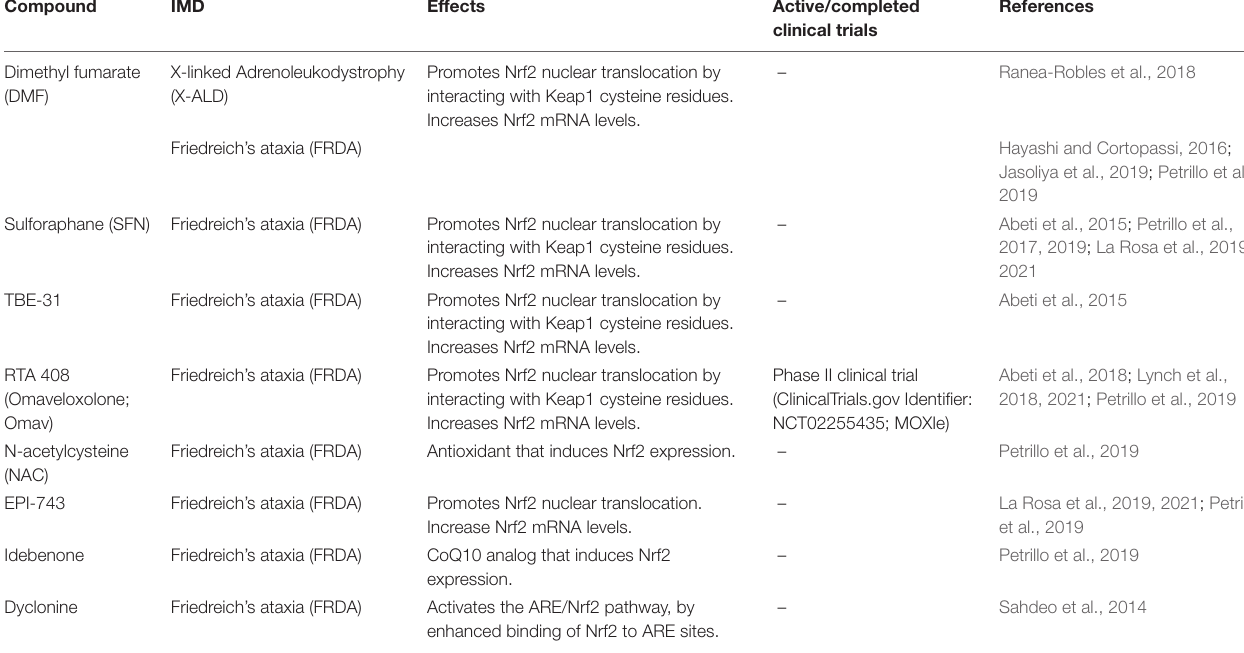
TABLE 1 | Summary of Nrf2 modulators evaluated in cellular and animal models, as well as in samples from patients affected by inherited metabolic disorders (IMD).